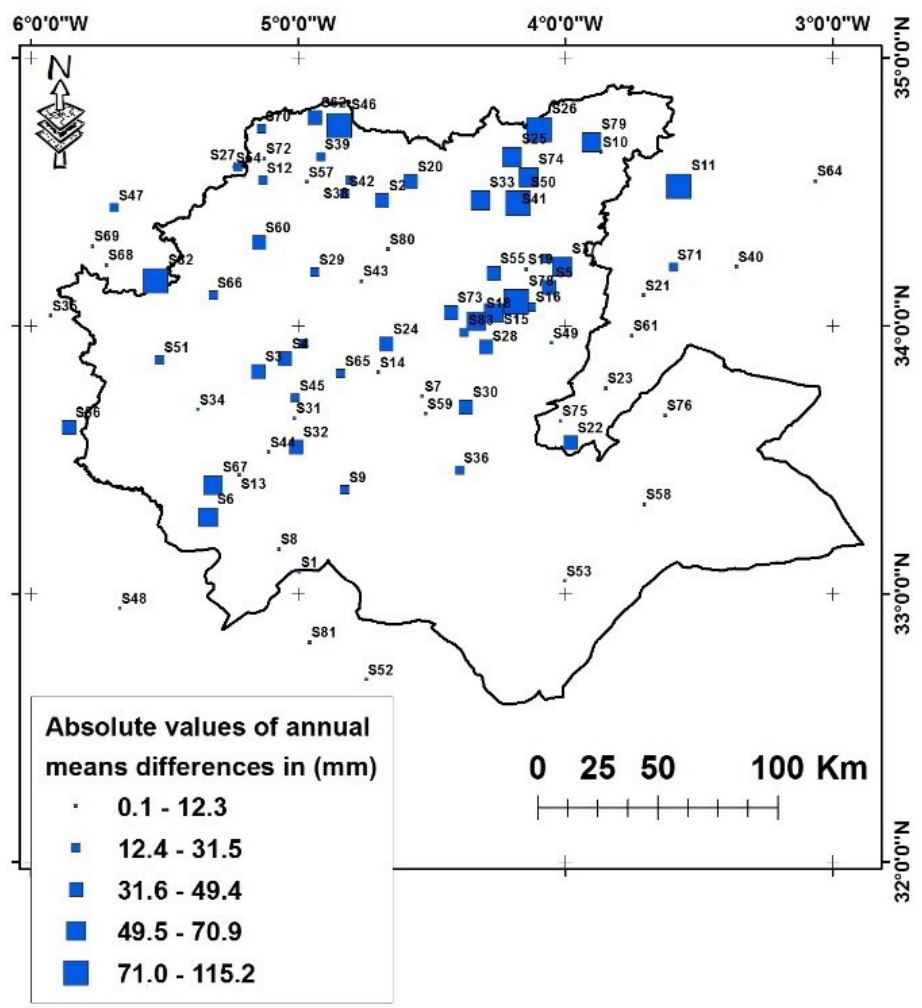
Figure 6. At the top, the comparison between the annual averages of the two types of data, at the bottom the absolute difference with the observed